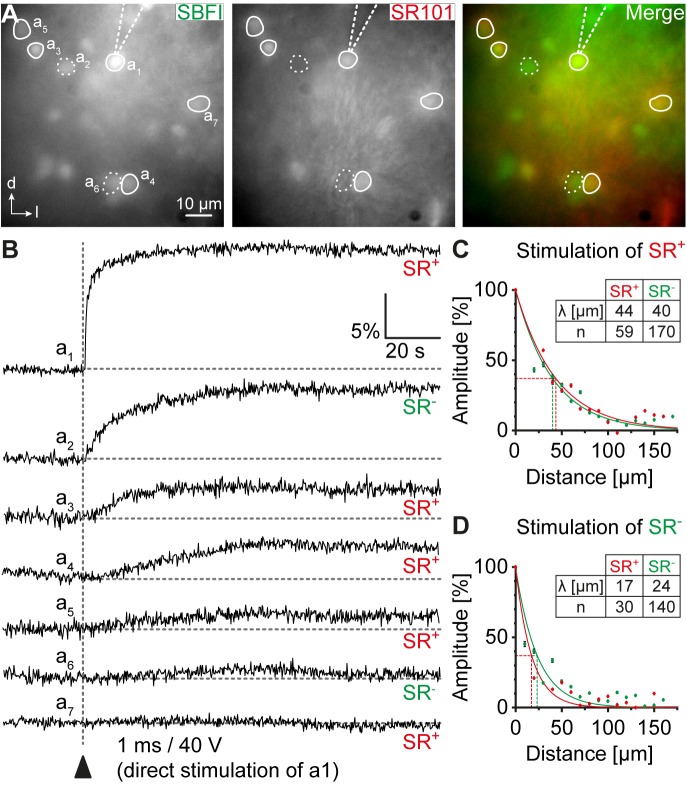
Na+ diffusion within glial networks. (A) IC cells were loaded with SBFI-AM (left). Astrocytes were identified by SR101-labeling (middle). (B) Electrical stimulation of a single astrocyte resulted in Na+ transients in the stimulated cell (a1) and in neighboring astrocytes (a3-a5, a7; SR+) and non-astrocytic cells (a2, a6; SR-). (C,D) Na+ diffusion in astrocytes and non-astrocytic cells could be elicited by stimulation of both astrocytes (C) and non-astrocytic cells (D). The amplitude of Na+ transients depended on the distance from the stimulated cell. λ denotes the length constant of the decay. n represents the number of analyzed cells and is provided within the diagrams. Shown are mean values ± SEM.